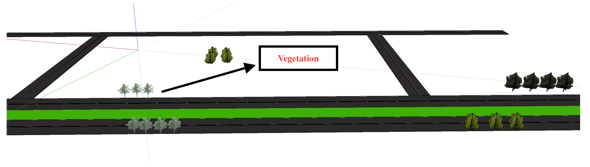
Figure 11: Vegetation